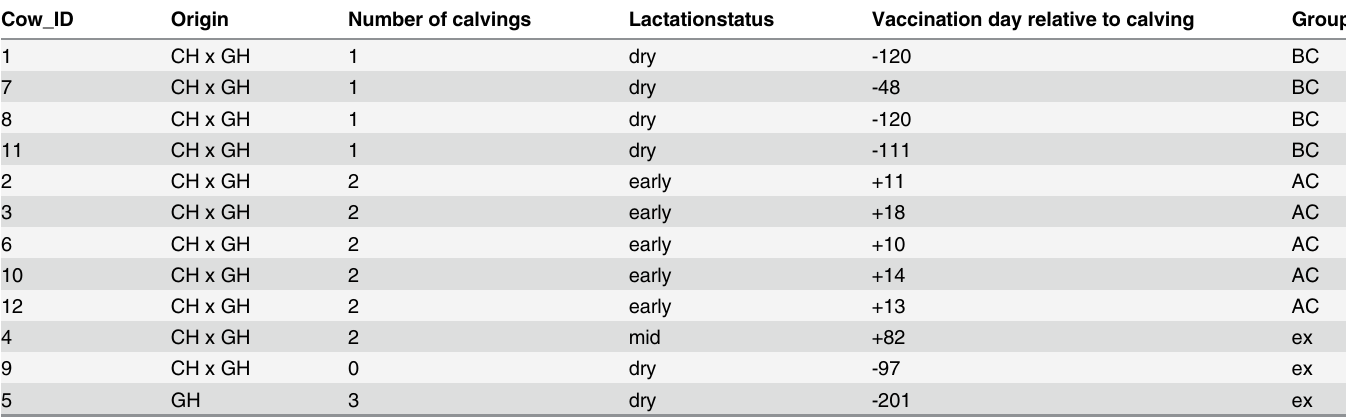
Table 1. Characteristics of cow groups formed by cluster